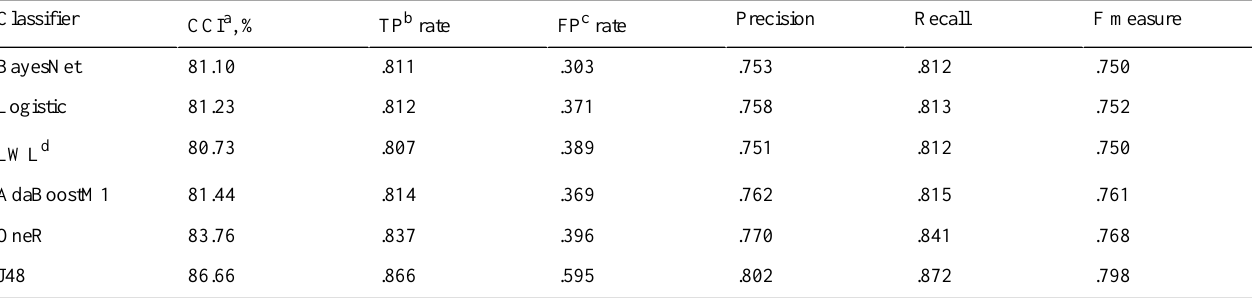
Table 12. Predicting the intention to use a mobile learning platform based on attitude, the subjective norm, and perceived behavioral